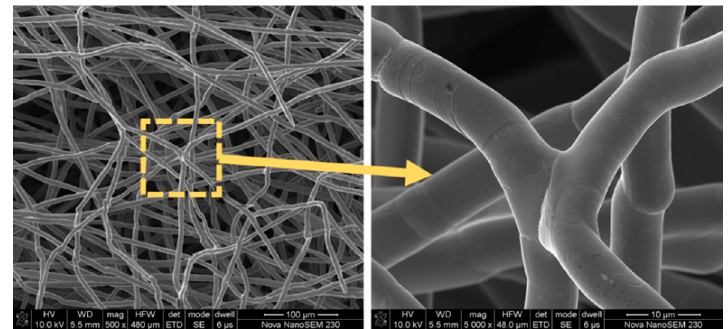
Figure 1. Scanning electron microscopy image of 316L stainless steel fiber felts with fiber diameters of 8 μ m sintered at 1200 °C for 2 h.